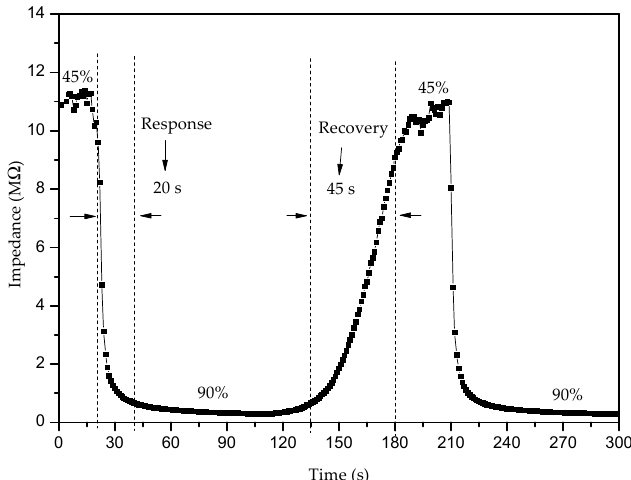
Figure 13. Response and recovery times obtained for Ni 0.1 Mg 0.9 Fe 2 O 4 in the RH range of 45–90% at the working temperature of 25 °C.